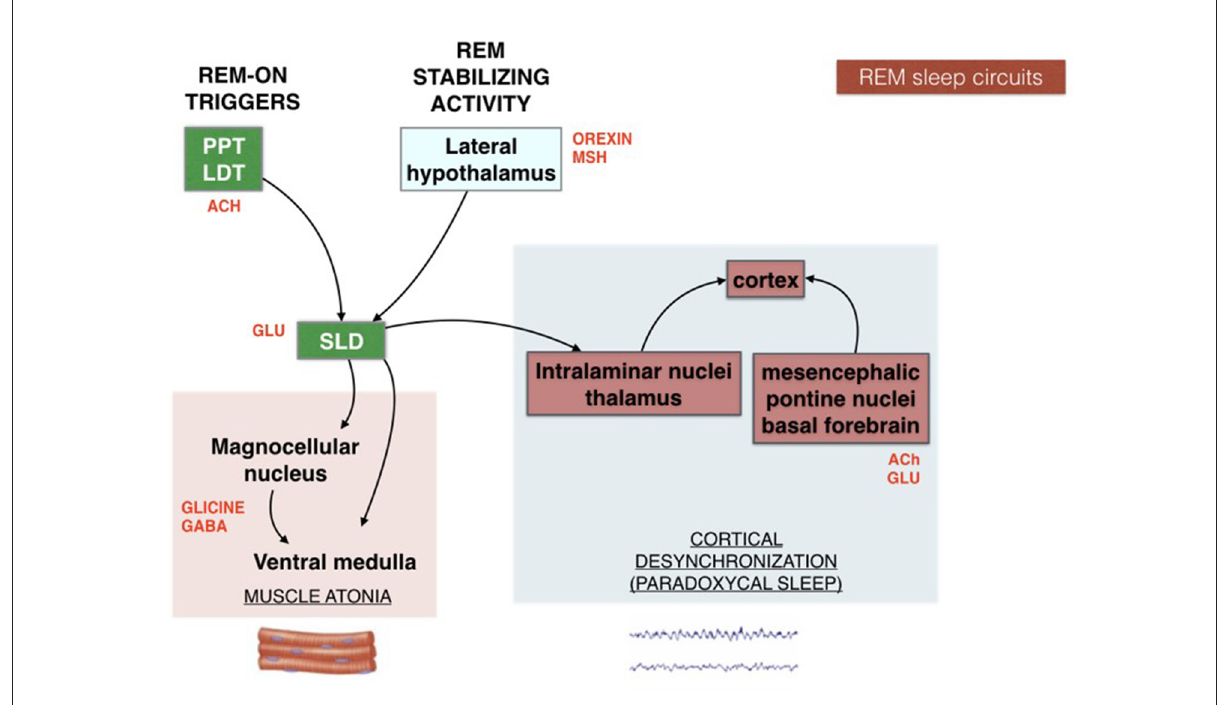
FIGURE4 Schematic representation of REM sleep